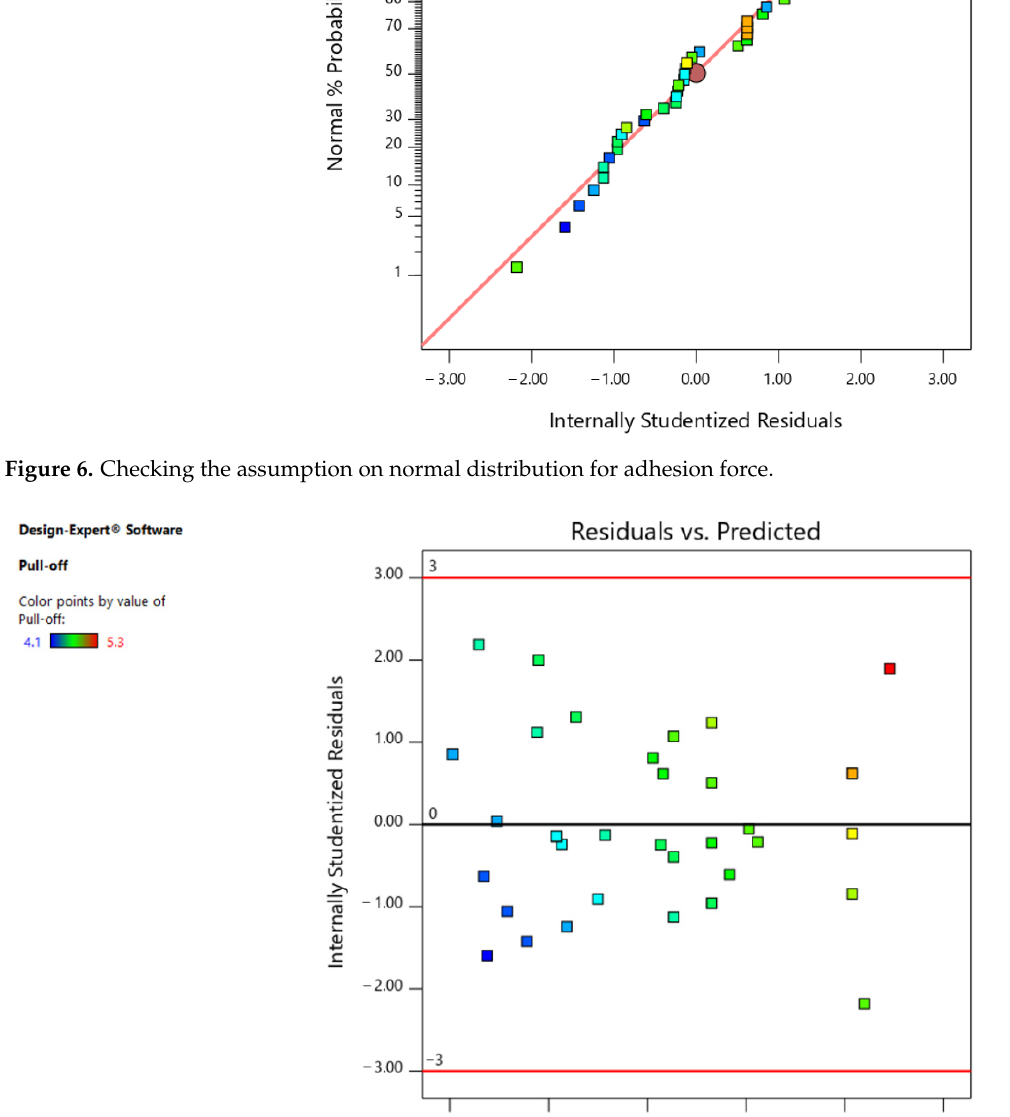
Figure 7. Residuals—predicted values for adhesion force.